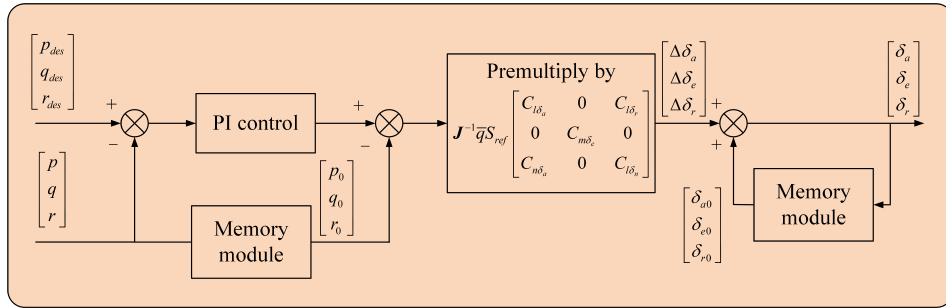
Figure 10. The control block diagram of the angular rate